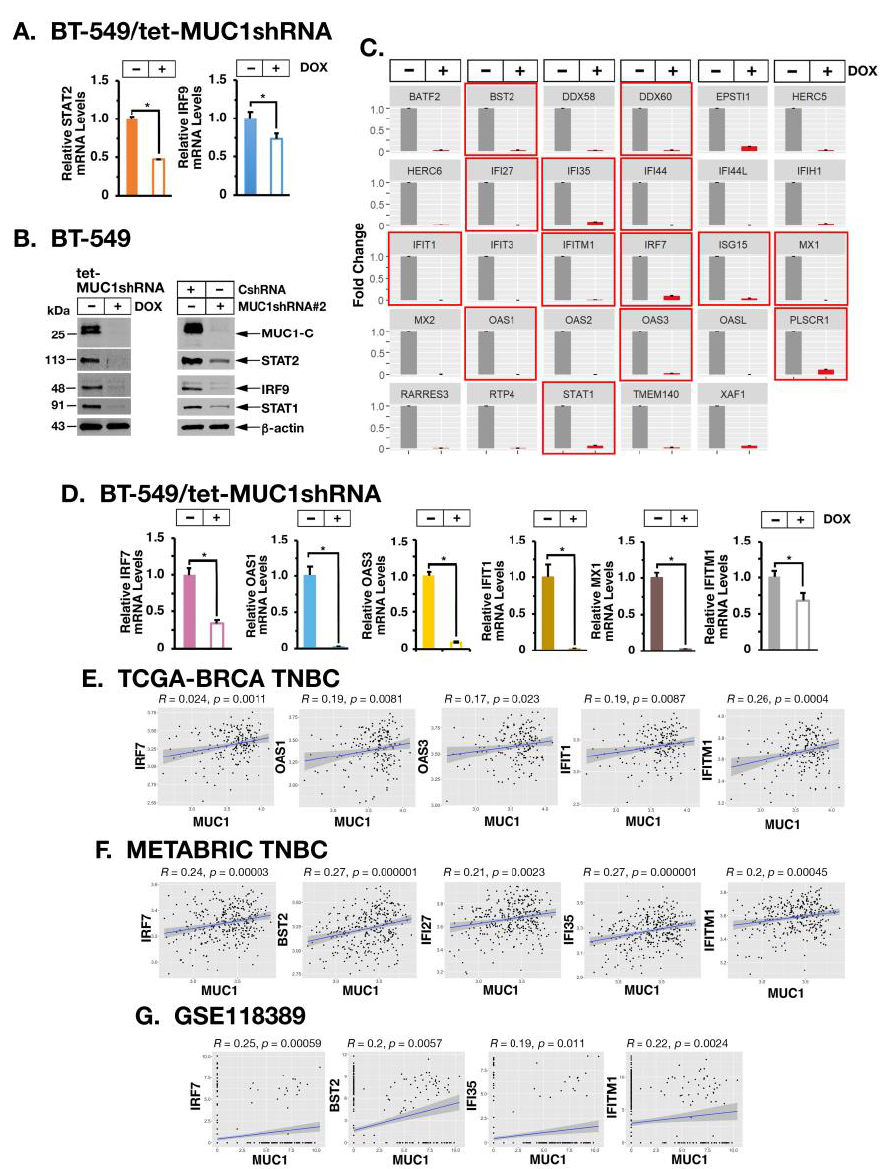
Figure 4. MUC1-C induces expression of U-ISGF3 target genes. ( A ) BT-549/tet-MUC1shRNA cells treated with vehicle or DOX for 7 days were analyzed for STAT2 and IRF9 mRNA levels by qRT-PCR. The results (mean ± SD of 4 determinations) are expressed as relative mRNA levels compared to that obtained for vehicle-treated cells (assigned a value of 1). ( B ) Lysates from (i) BT-549/tet-MUC1shRNA cells treated with vehicle of DOX for 7 days and (ii) BT-549/CshRNA and BT-549/MUC1shRNA#2 cells ( right ) were immunoblotted with antibodies against the indicated proteins. ( C ) . RNA-seq performed in triplicate on BT-549/tet-MUC1shRNA treated with vehicle (gray bars) or DOX (red bars) for 7 days was analyzed for expression of the indicated U-ISGF3 target genes. The results are expressed as the mean ± SD of 3 determinations. IRDS genes are highlighted with red boxes. ( D ) BT-549/tet-MUC1shRNA cells treated with vehicle or DOX for 7 days were analyzed for the indicated IRDS mRNA levels by qRT-PCR. The results (mean ± SD of 3 determinations) are expressed as relative mRNA levels compared to that obtained for vehicle-treated cells (assigned a value of 1). ( E , F ) Scatter plots showing correlations of MUC1 with the indicated IRDS genes in TNBCs from the TCGA-BRCA ( E ) and METABRIC ( F ) cohorts. ( G ) Scatter plots of the correlation between MUC1 and the indicated IRDS genes in single TNBC cells as analyzed from the GSE118389 scRNA-seq dataset. The asterisk (*) denotes a p -value < 0.05. Uncropped Western Blots can be found at supplemental original